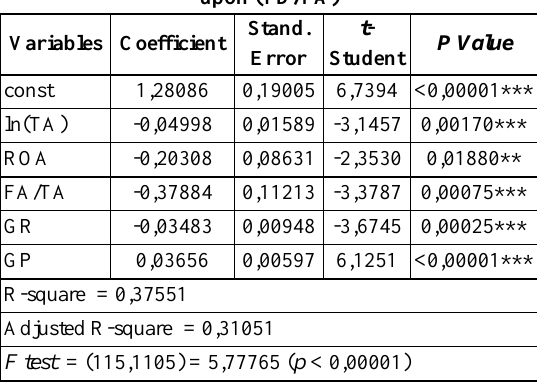
Table 3. Analysis of Impact of Selected Determinants upon (TD/TA) Stand. Variables Coefficient